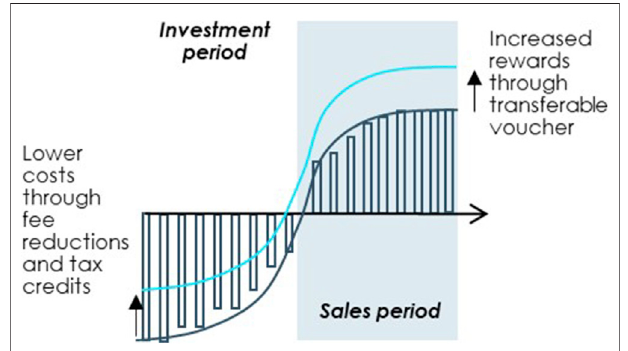
FIGURE 8 | Improving the OMP investment case through targeted fi nancial incentives. Note: Illustrated example. Source: Copenhagen Economics and the OD Expert